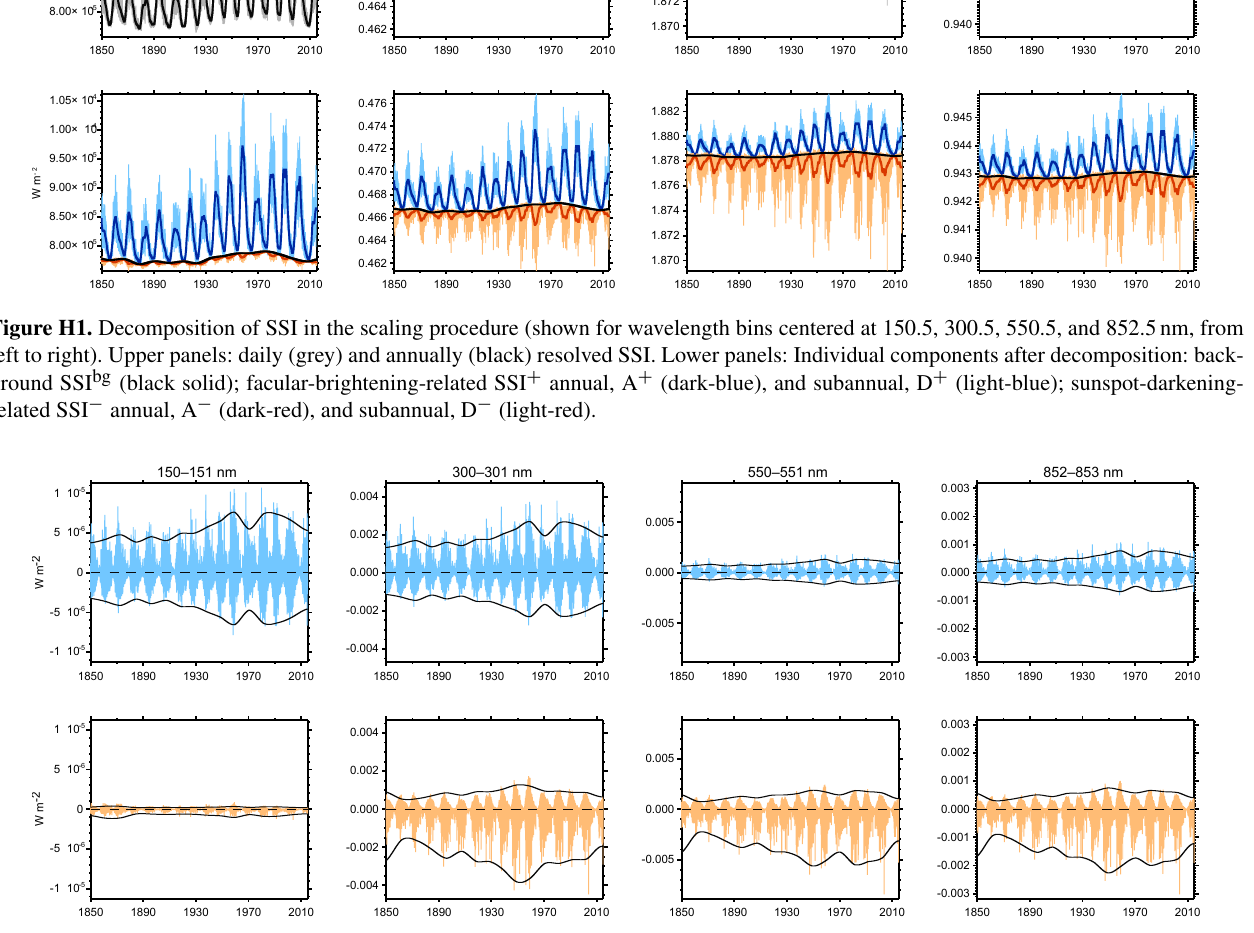
ponential correction f to the obtained offsets: 1 − exp ( − 0 . 1<SSN> ) f = 1 + exp ( − 0 . 1<SSN>